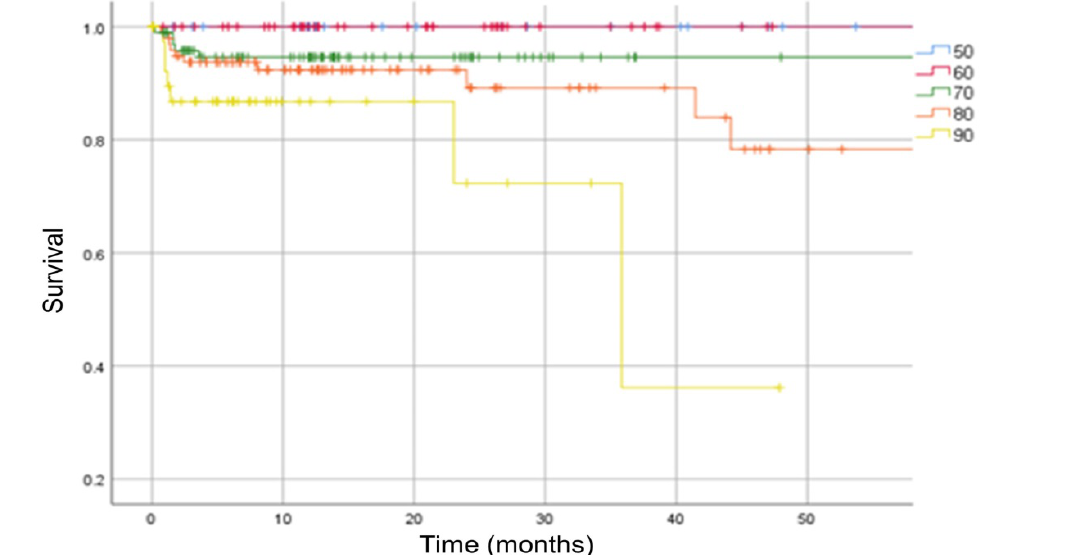
Figure 4. Kaplan-Meier survival curve. The analysis is separated in patients below 50 years old (blue 50 curve), then at 10-year intervals. Vertical marks indicate